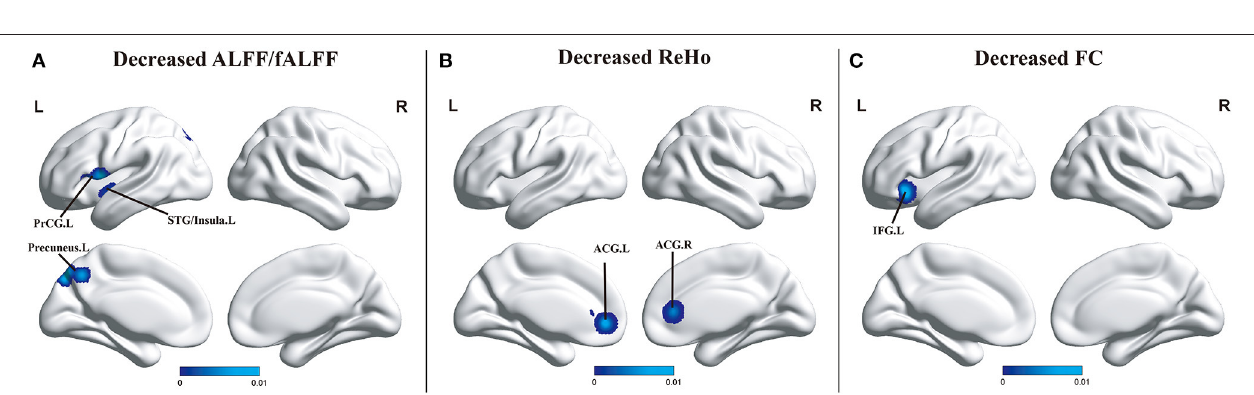
FIGURE 2 | (A) Brain regions showing decreased ALFF/fALFF in patients with MCI compared with HCs. (B) Brain regions showing increased FC in patients with MCI when compared with HCs. (C) Brain regions showing decreased FC in patients with MCI compared with HCs. The color bar represents the p -value. Areas with decreased change relative to controls are displayed in blue, and areas with increased change are displayed in red. Results are thresholded at p < 0.01 cluster-corrected and p < 0.05 family-wise error corrected. Abbreviations: MCI, mild cognitive impairment; HCs, healthy controls; ALFF/fALFF, the amplitude of low-frequency fluctuation/fractional amplitude of low-frequency fluctuation; FC, functional connectivity; MFG, middle frontal gyrus; PreCG, precentral gyrus; STG, superior temporal gyrus; R, right; L, left.